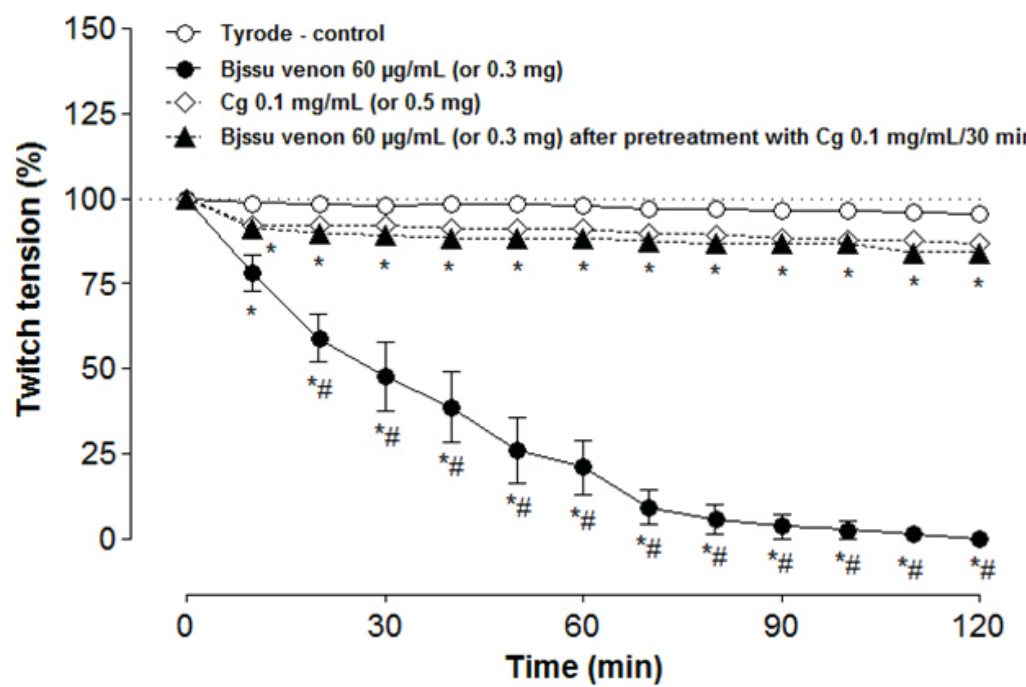
Figure 4. Twitch tension of mouse isolated phrenic nerve-diaphragm preparations under indirect stimuli, in percentage (each point represents the mean ± SEM, n = 6). Pretreatment of preparations with 0.1 mg/ mL (or 0.5 mg) Cg hydroalcoholic extract for 30 minutes, followed by 60 μg/mL (or 300 mg or 0.3 mg) Bjssu venom addition during 120 minutes. * p < 0.05 compared to Tyrode control for all periods (except 0). # p < 0.05 compared to Cg extract alone or to pretreatment with Cg extract.